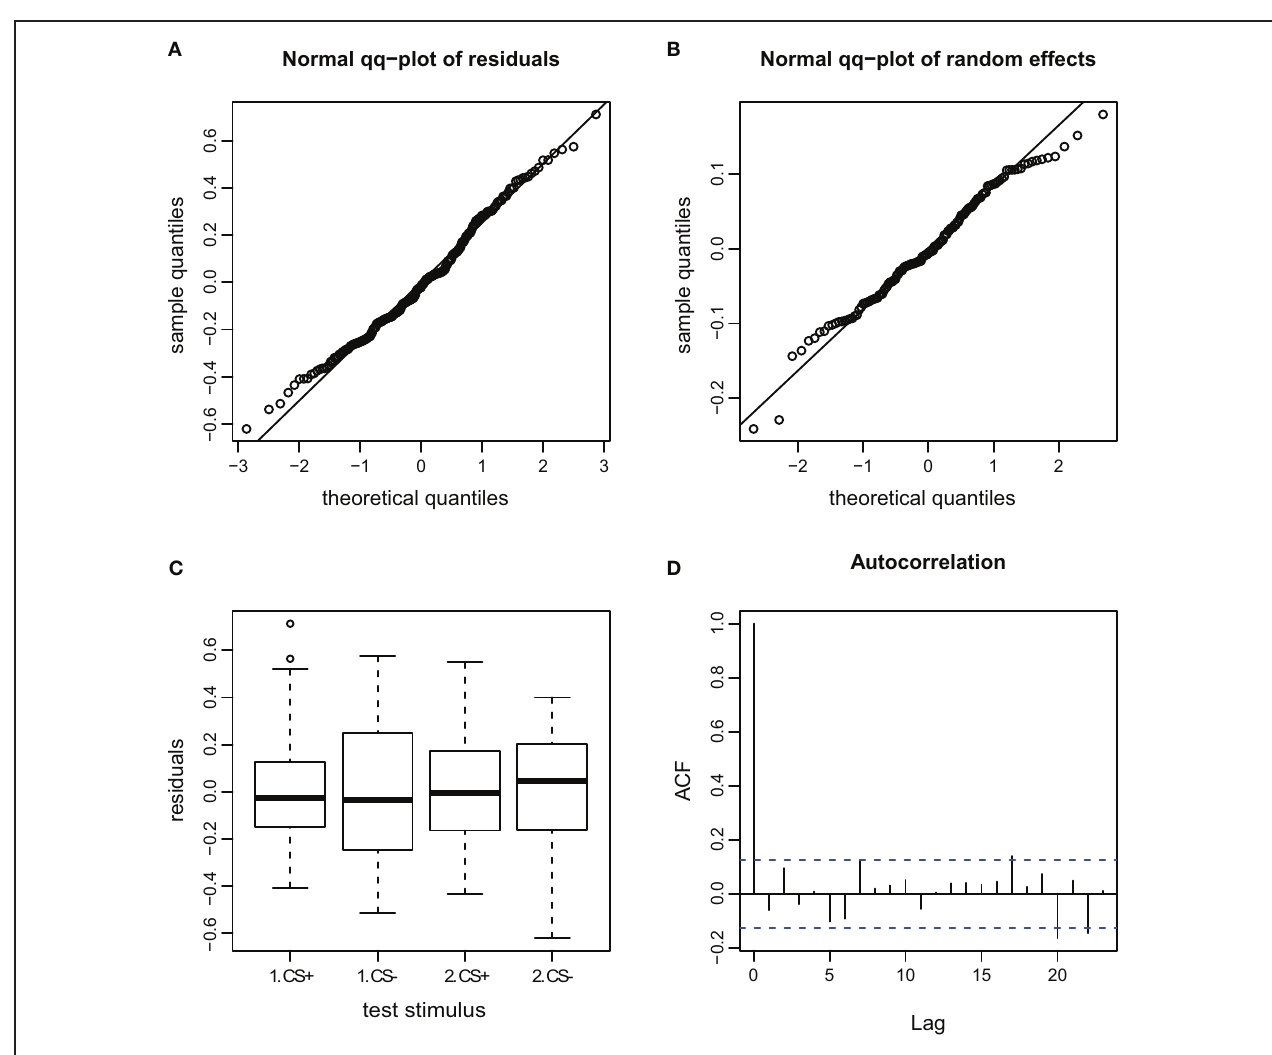
FIGURE A6 | Goodness of fit and diagnostic plots of residuals for linear mixed model for the AI during escape in APIS. (A) Quantile probability plot showing the quantiles of the residuals of observed AI vs. the theoretical quantiles of a normal distribution. The observed AI of the escape subset follows a normal distribution, and the heavy tail for the upper quantiles that was apparent in the full dataset ( Figure A4 ) is gone. This indicates that none-escape responses were responsible for the low variation (as in the velocity observations seen in Figure A5 ). (B) Quantile probability plot of the random effect (bee), indicating that the residuals of the AI among the tested